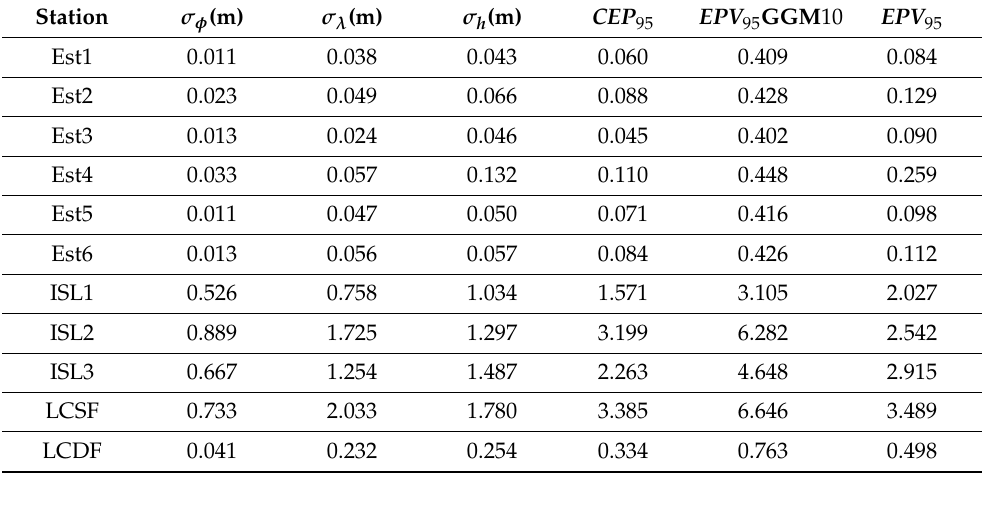
Table 6. Results of the CEP and EPV of Precise Point Positioning according to the INEGI techni- cal standard.